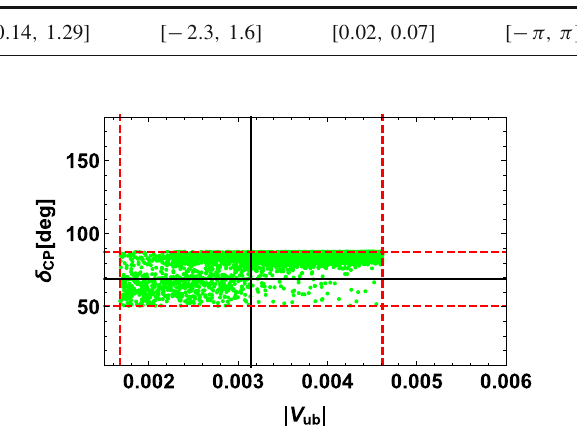
Fig. 1 Distribution on | V ub | – δ CP plane, where black lines denote observed central values of | V ub | and δ CP , and red dashed-lines denote three times 1 σ interval